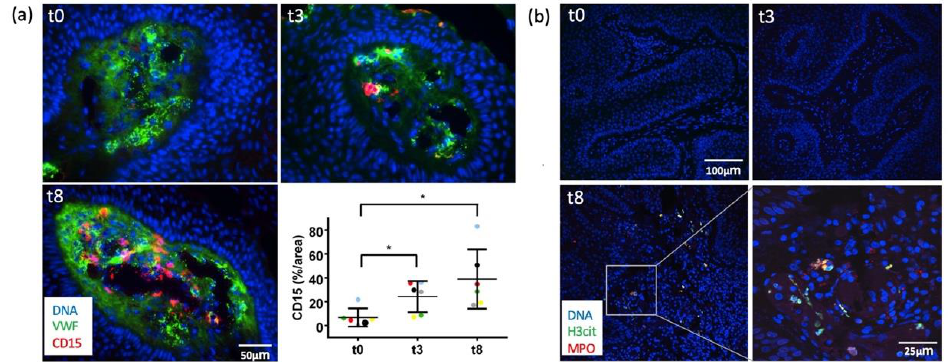
Figure 3. ( a ) Ingenol mebutate (IM) mediates von Willebrand factor (VWF) secretion, neutrophil infiltration, and NET formation. Tissue sections were stained for VWF (green), and CD15 for neutrophils (red). Nuclei are stained with DAPI (blue). After topic administration of IM, VWF fibers are detectable within the vessel lumen indicating endothelial cell activation. These VWF networks are associated with a massive increase of luminal neutrophils over time (please see for quantification the graphical inset, the different colored dots indicate warts of different patients). Results are expressed as relative area (%) of the vessel lumen and data are presented as mean ± SD of each patient. Tissue of six patients (n = 6) was analyzed (* p ≤ 0.05); ( b ) tissue sections of all six patients (n = 6) were stained for H3cit (green) as a marker of NET formation and MPO (red) as a marker for neutrophils at the indicated time-points. Chromatin was stained with Hoechst (blue). After 8 h (t8), neutrophil infiltration and NET formation was visible. Exemplary presentation of patient 6. The evaluations of additional patients can be found in the Supplementary Material Figure S3.